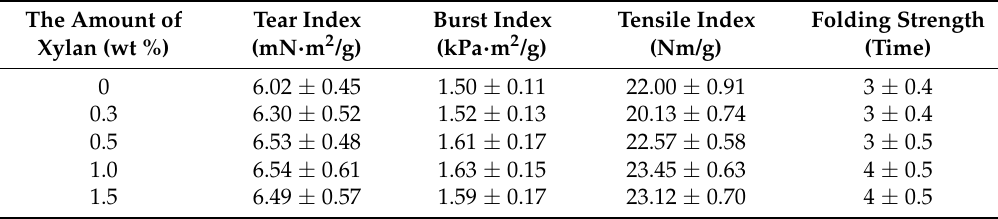
Table 2. Influence of xylan with different amounts on the mechanical properties of handsheets. The Amount of Xylan (wt %)